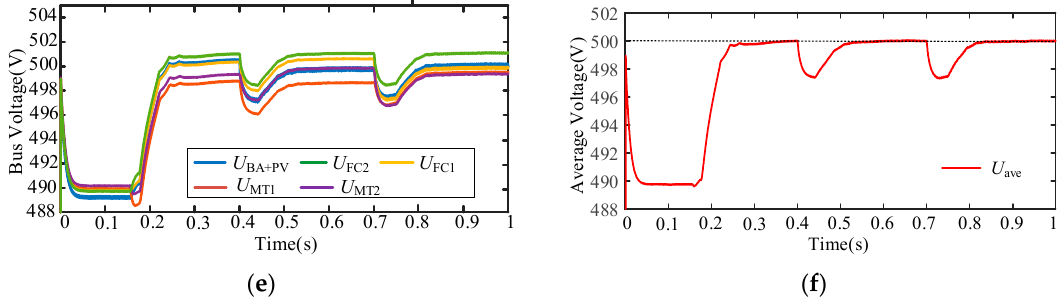
Figure 8. Effect of the proposed scheme under changing load. ( a ) the output power of each generator; ( b ) the incremental cost of each generator; ( c ) the virtual resistance in each economical regulator; ( d ) the estimated voltage in each voltage regulator; ( e ) the bus voltages; ( f ) the average voltage of the system.